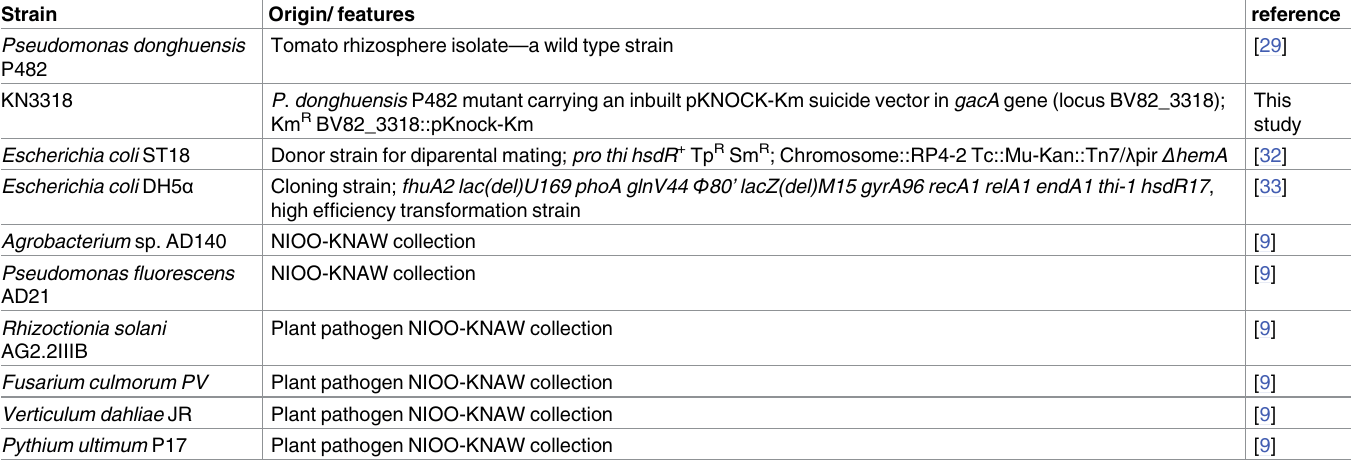
Table 1. The list of the bacterial, fungal and oomycetes strains used in this